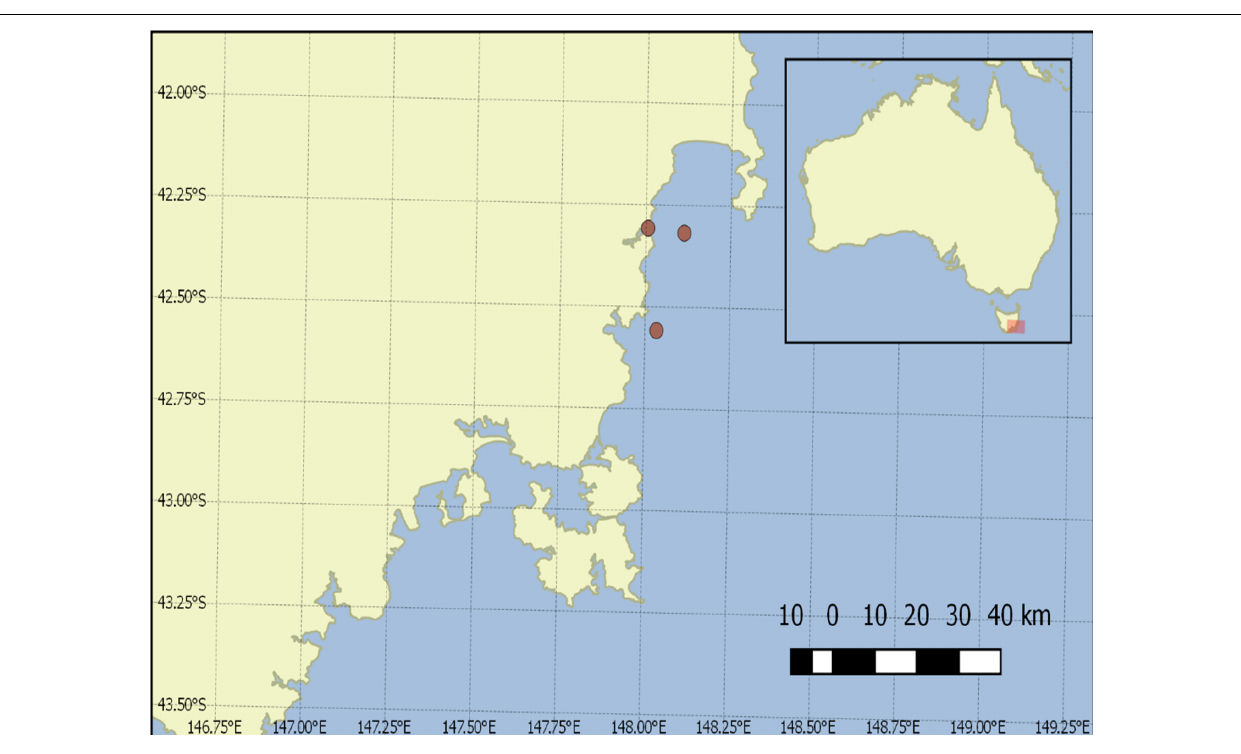
FIGURE 2 | Sample collection points in Great Oyster Bay and Spring Bay,